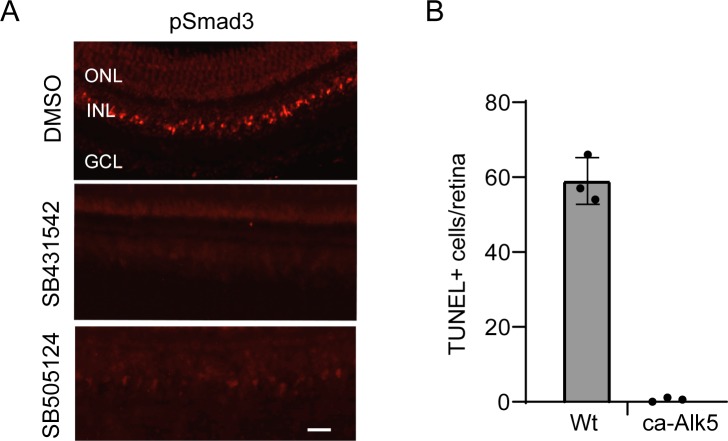
Alk5-dependent pSmad3 expression.(A) Inhibition of Tgfb receptor kinase activity suppresses pSmad3 expression. Two different Alk5 kinase inhibitors were tested. pSmad3 immunofluorescence is shown on retinal sections from uninjured fish retina. (B) Quantification of TUNEL+ cells at the site of retinal injury in heat shock-treated Wt and hsp70:ca-Alk5 fish. Scale bar is 50 microns. Error bars are SD.